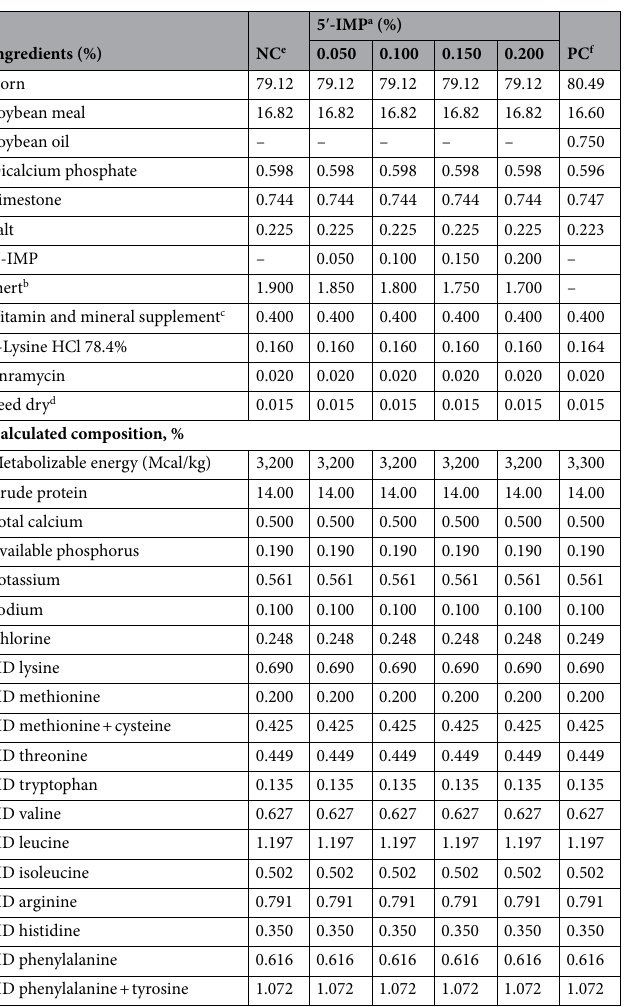
Table 6. Composition of experimental diets. a Inosine-5 ′ -monophosphate. b Kaolinite. c Provided per kilogram: vitamin A, 30,000 UI; vitamin D3, 5000 UI; vitamin E, 120 UI; vitamin K, 5 mg; vitamin B12, 120 mcg; niacin, 150 mg; calcium pantothenate, 75 mg; folic acid, 8 mg; choline chloride, 0.48 g; iron, 350 mg; copper, 15 mg; manganese, 250 mg; zinc, 0.75 g; iodine, 10 mg; selenium, 3 mg. d Antioxidant. e Negative control (0.00% 5 ′ -IMP and 3200 kcal ME/kg). f Positive control (0.00% 5 ′ -IMP and 3300 kcal